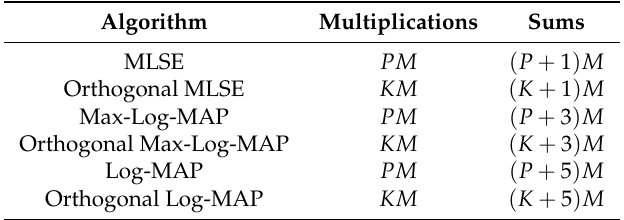
Table 1. Number of multiplications and sums in each state of the trellis for different estimators. Maximum likelihood sequence estimation (MLSE) and maximum a posteriori probability